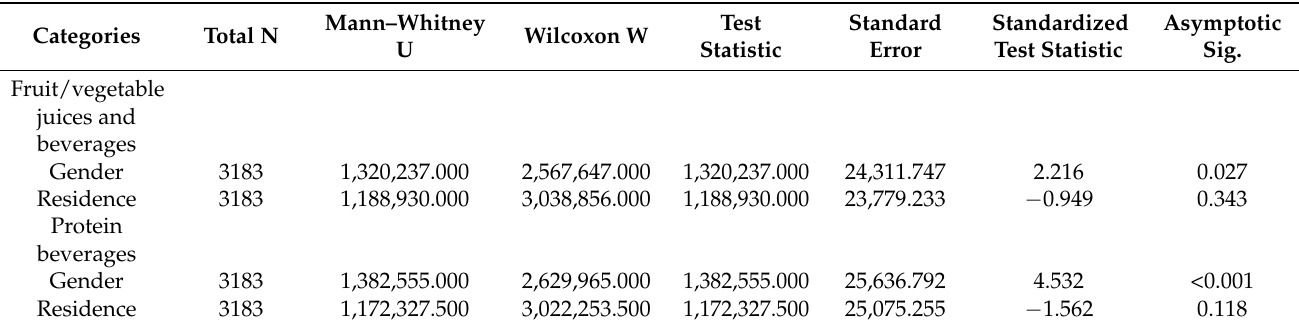
Table A8. Differences of the proportions of sugar intake from each kind of beverage in total sugar intake from